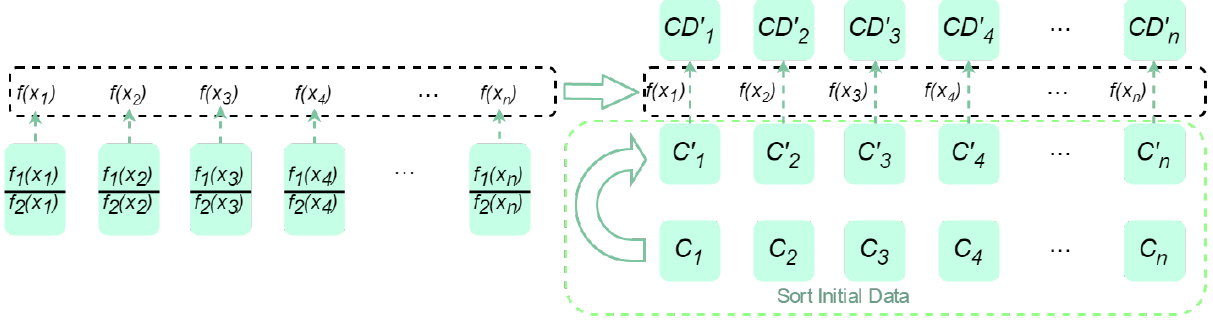
Figure 3. The process of discretization for the initial cooling load.